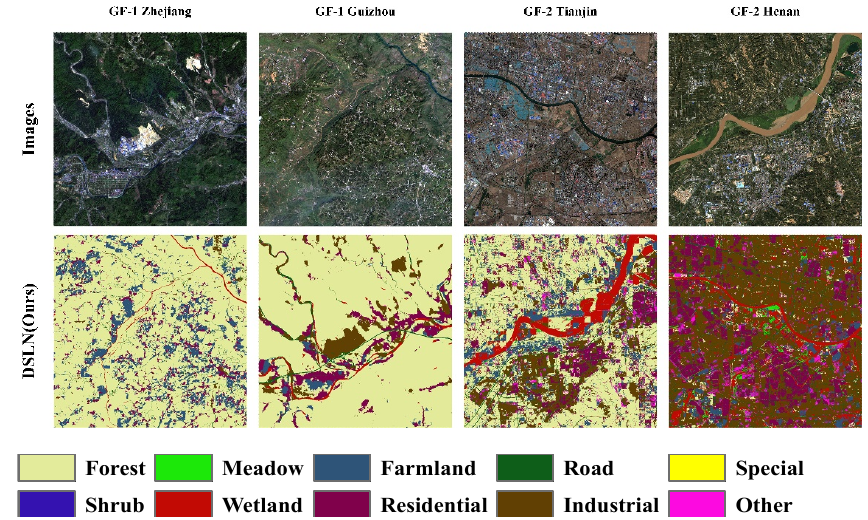
Figure 5. Predictions on different space, different sensor images.